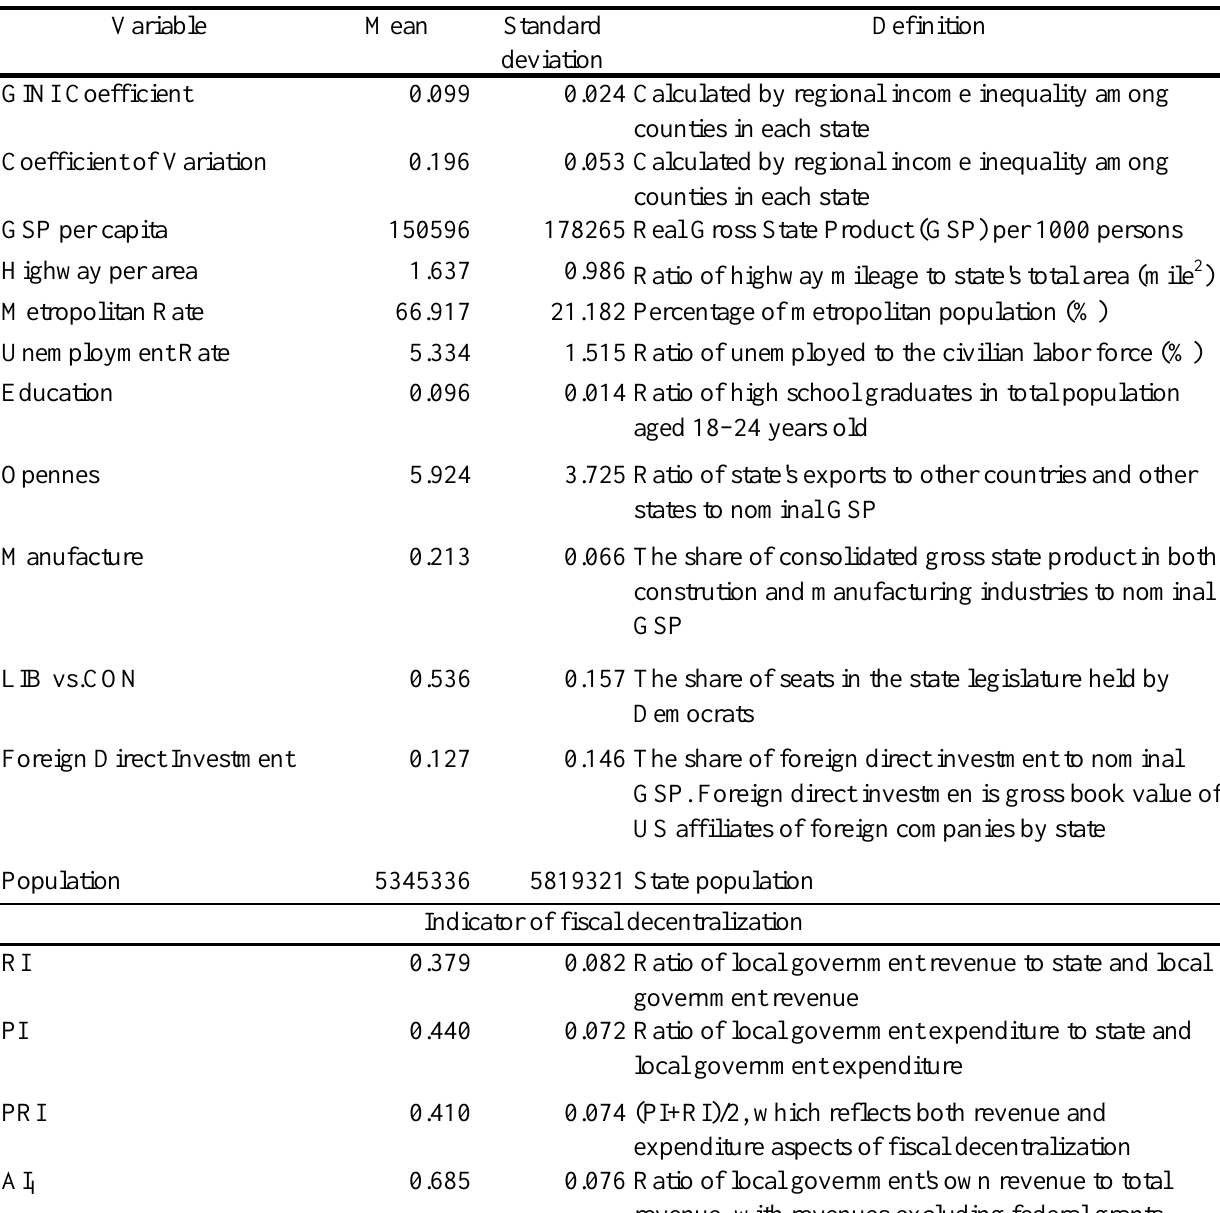
Table 1: Variable Definitions, Means and Standard